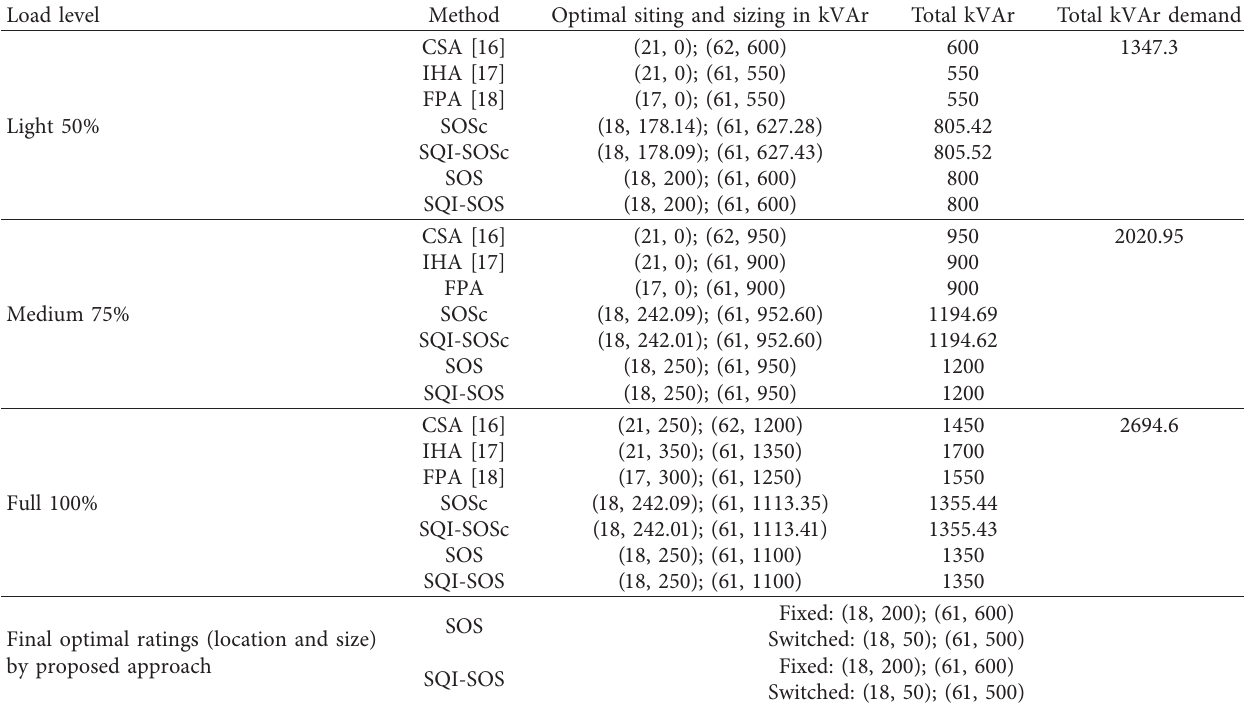
Table 9: Optimal siting and sizing of capacitors for the 69-bus system with the CP load model at different load levels.